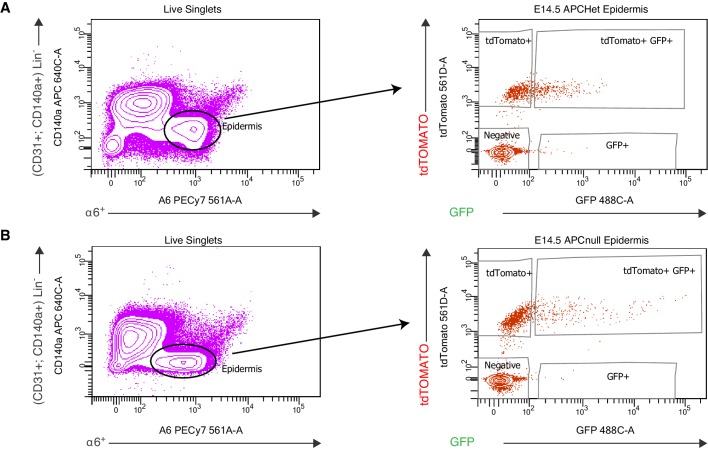
FACS purification strategy to isolate WNThi skin progenitors from Apc embryonic skin.(A–B) FACS purification of WNThi cells from Apcfl/+; Rosa26-lox-stop-lox-dtTomato embryos (A) and from Apcfl/fl Rosa26-lox-stop-lox-dtTomato embryos (B). Both types of embryos were transduced at E9.5 with an LV harboring a WNT GFP reporter and Pgk-Cre and then harvested at E14.5. WNT-reporterhi (a6+ tdTomato+ GFP+) and WNT-reporterlo (a6+tdTomato+) progenitors were purified, while suprabasal (a6neg tdTomato+ GFPneg) epidermal cells and non-epidermal cells (Lin-: CD131+ and CD140a+) were eliminated.